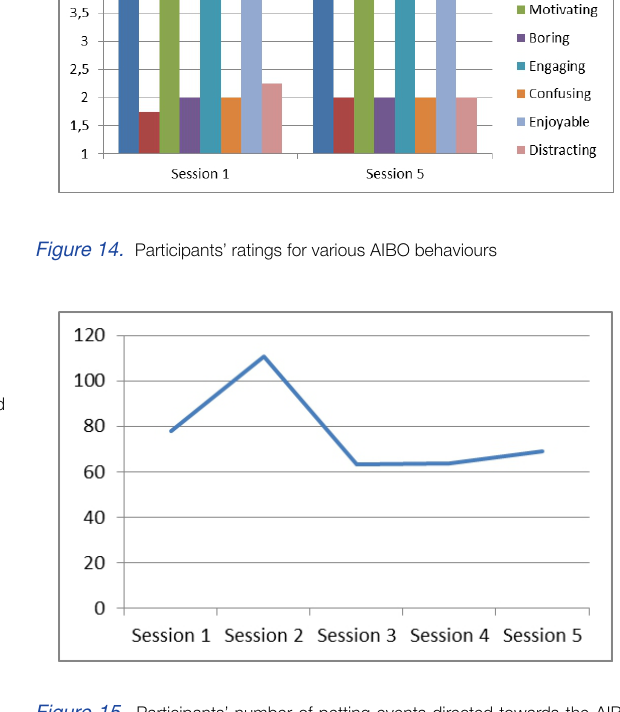
Enjoyable-Distracting: Session 1 (Z = − 2.573, Sig. = 0.01), Session 5 (Z = − 2.327, Sig. =